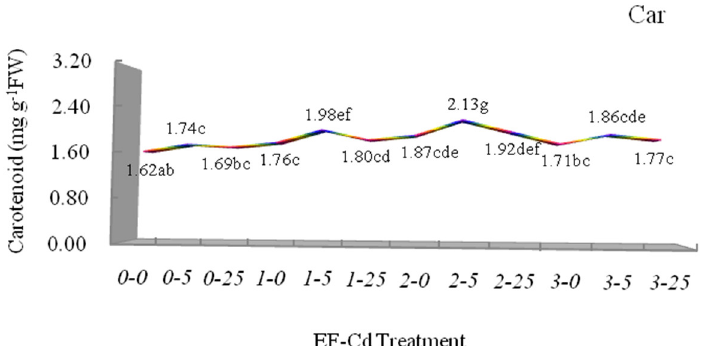
Figure 3. Effects of different EF-Cd treatments on the contents of Chlorophyll a (Chla), Chlorophyll b (Chlb), Total Chlorophyll (Chl) and Carotenoid (Car) in leaves of L. japonica . Different colors showed the different responses in L. japonica under EF-Cd treatments. Different letters indicate significant differences at the p < 0.05 level. Values represent mean ± SD.